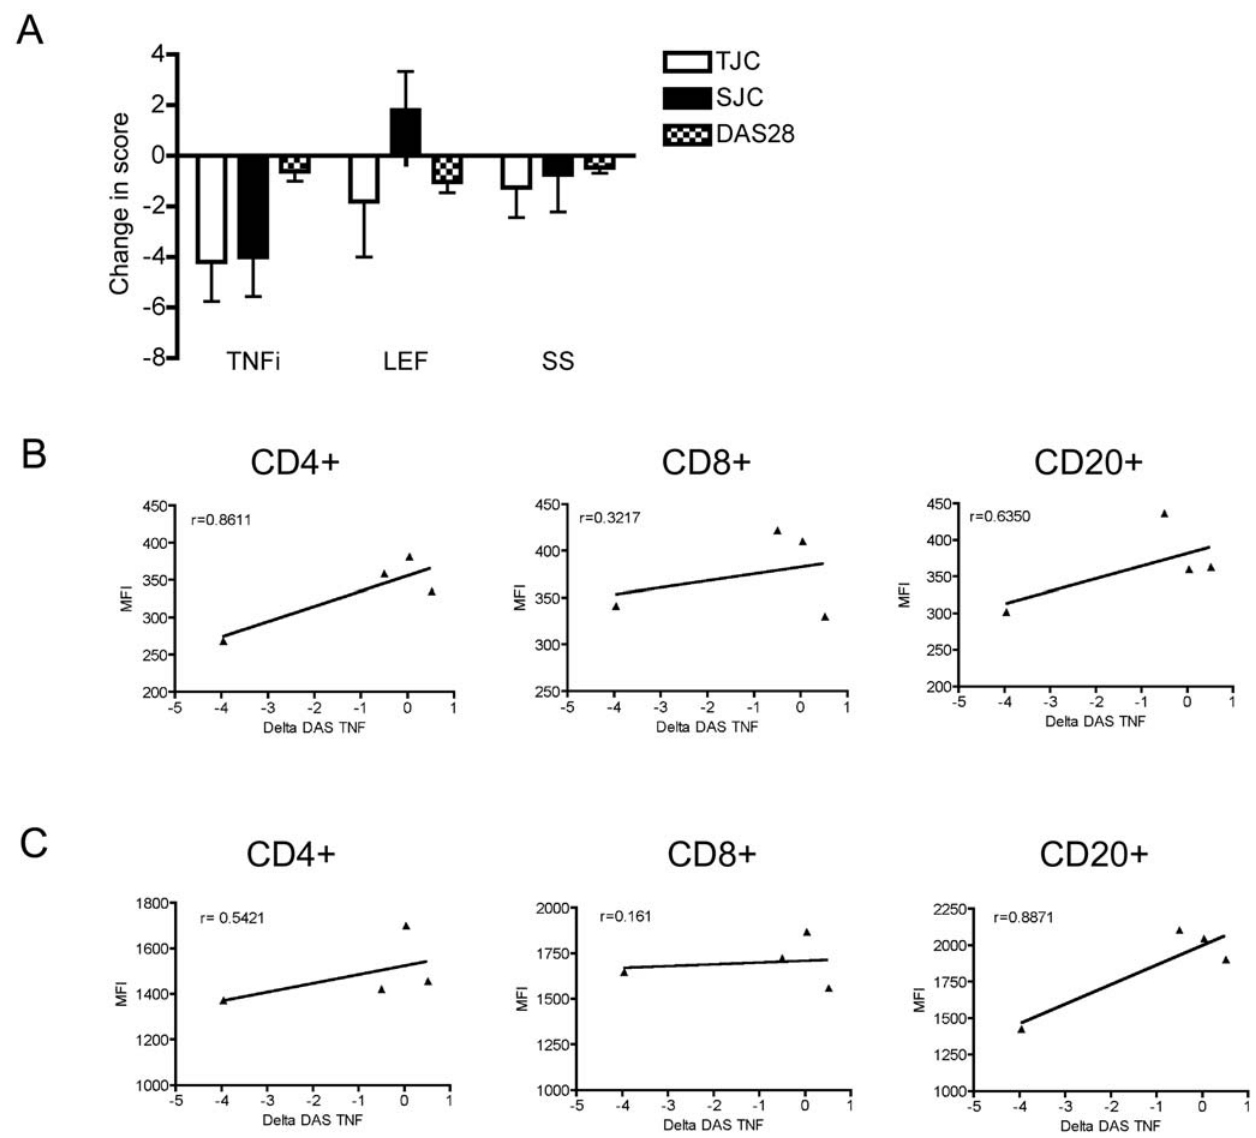
Figure 7. Phosphorylation levels correlate with changes in DAS28. (A) Changes in tender joint count (TJC), swollen joint count (SJC) and DAS28 between the time of sampling and baseline scores are recorded for TNF inhibitors (TNFi) (n=5, Enbrel or Humira), LEF (n=6) and systemic steroids (n=5). Values are the mean 6 SE. MFI values for (B) p-H3 (n=4) and (C) p-AKT (n=4) are plotted relative to changes in DAS in the PB CD4, CD8 and CD20 cell compartments, as